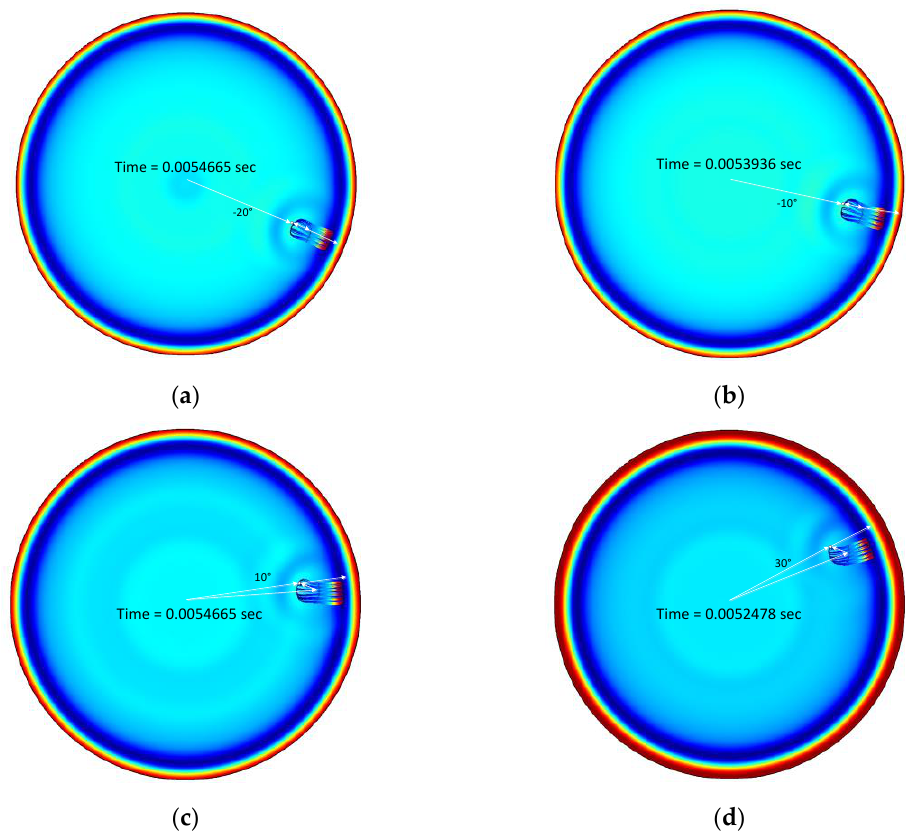
Figure 8. Total acoustic pressure field (surface plot) and local acceleration (streamline) for ( a ) −20°, ( b ) −10°, ( c ) 10° and ( d ) 30° AoA. Note that the white lines are intentionally inserted for visualizing the dominant propagation paths.